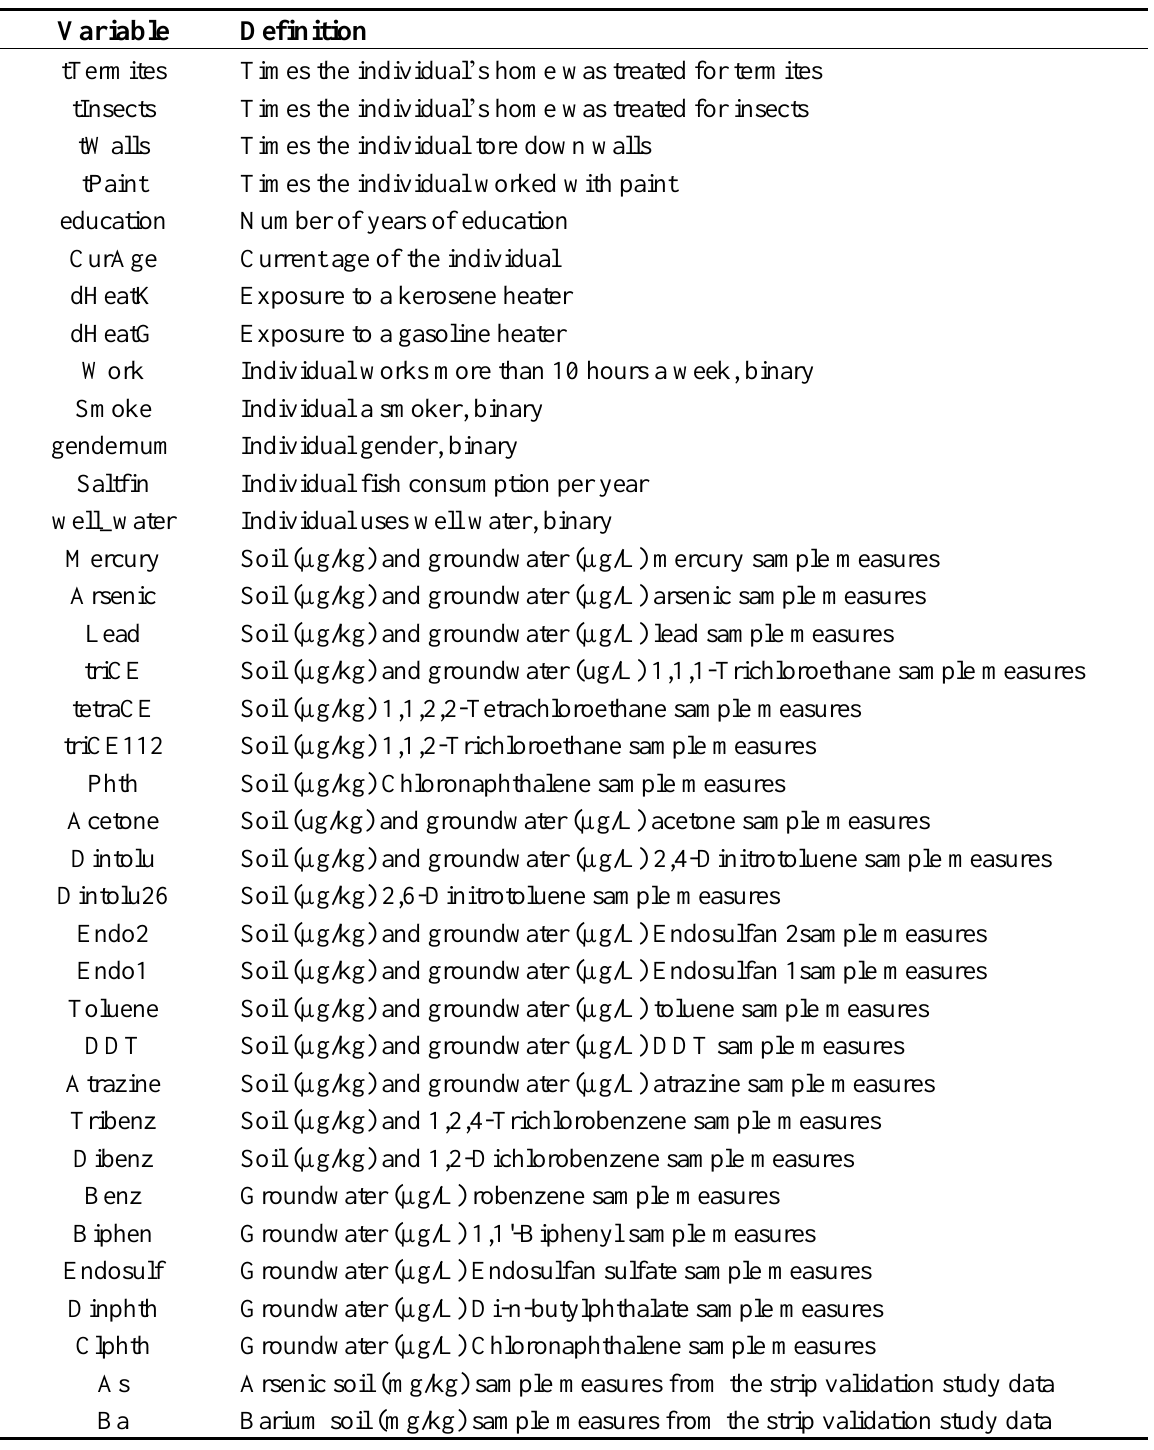
Table 2. Individual level and chemical variables applied in the study with associated